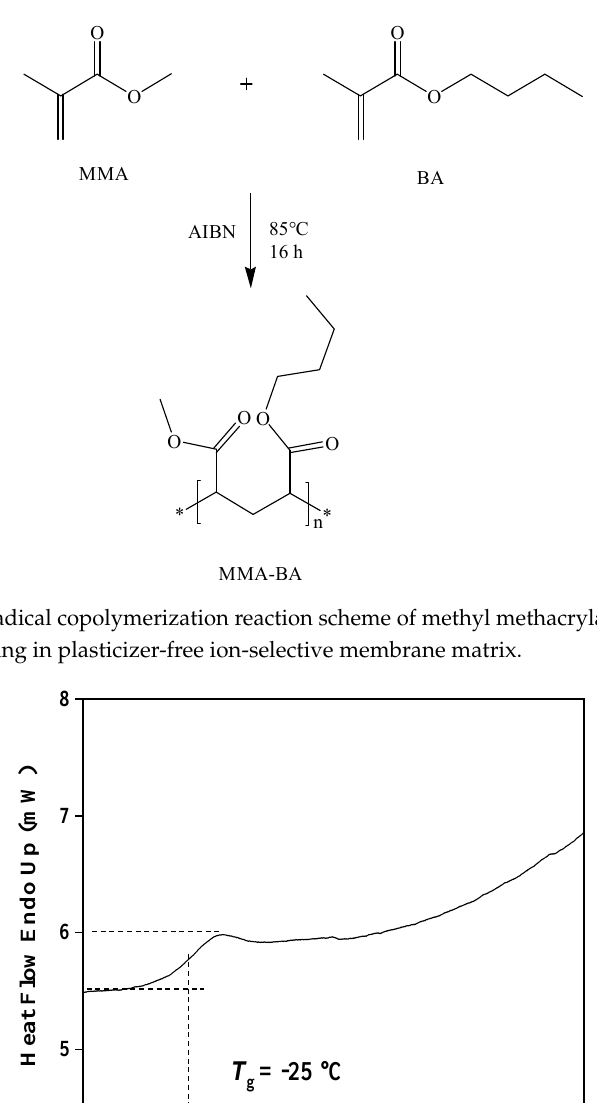
Figure 2. The glass ‐ transition temperature ( T g ) of the copolymer MMA ‐ BA. Table 1. The physical properties of the copolymer MMA-BA.